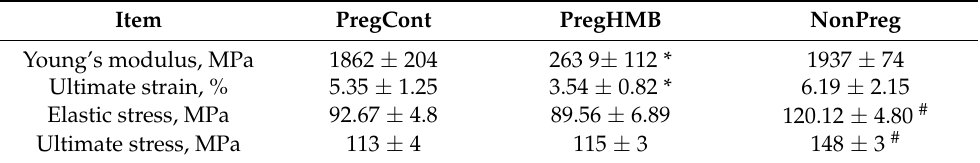
Table 2. Material parameters of femora from pregnant (control and supplemented with β -Hydroxy β -methylbutyrate (HMB)) and non-pregnant female spiny mice ( Acomys cahirinus